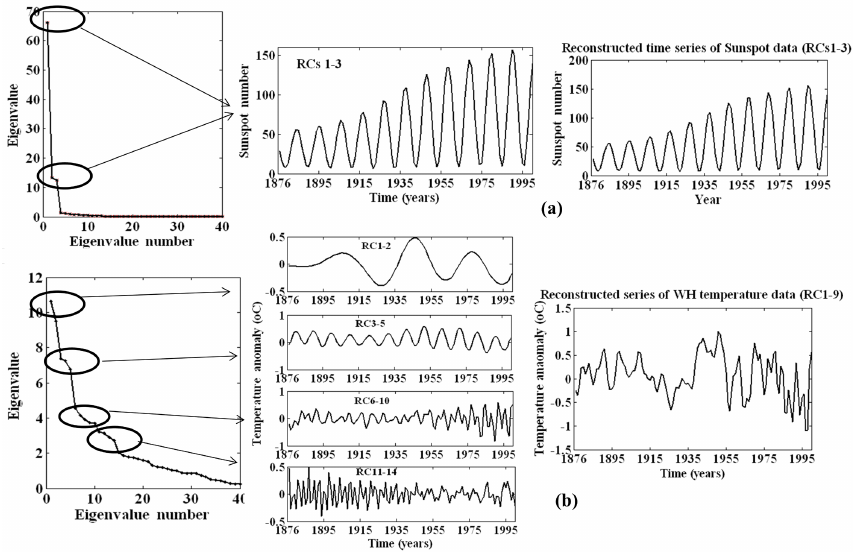
Figure 6. Singular spectra with their SSA decomposed components and their reconstructed time series for (a) sunspot number and (b) Western Himalayan temperature